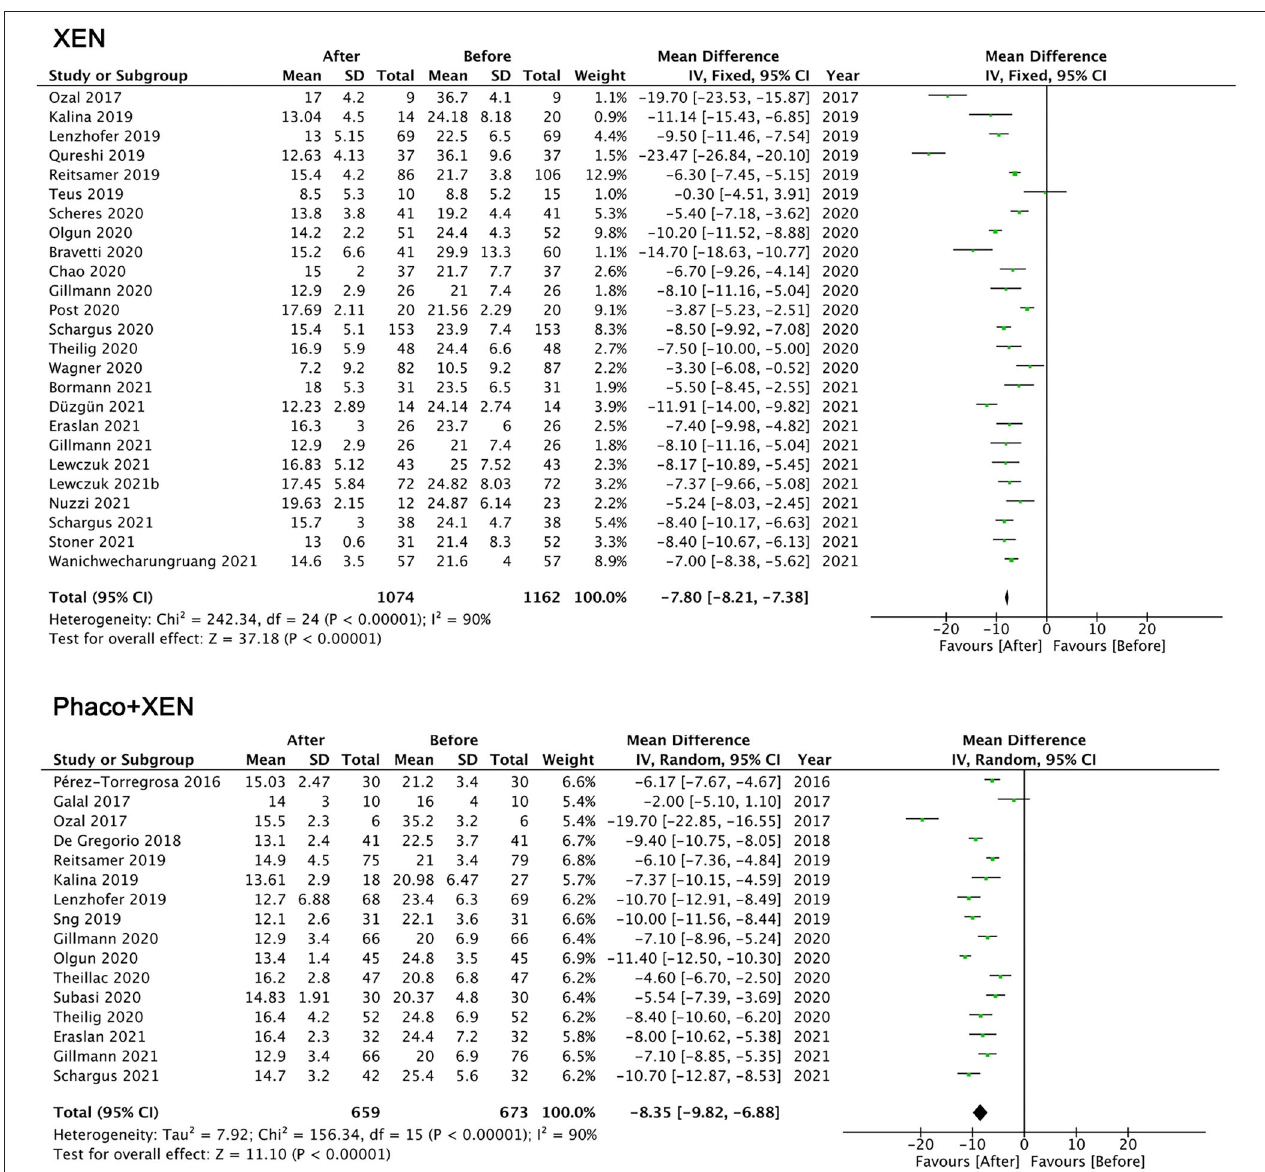
FIGURE 2 | Mean difference (MD) of the reduction in intraocular pressure between the baseline and the final follow-up by XEN alone, phacoemulsification combined with XEN (phaco + XEN).